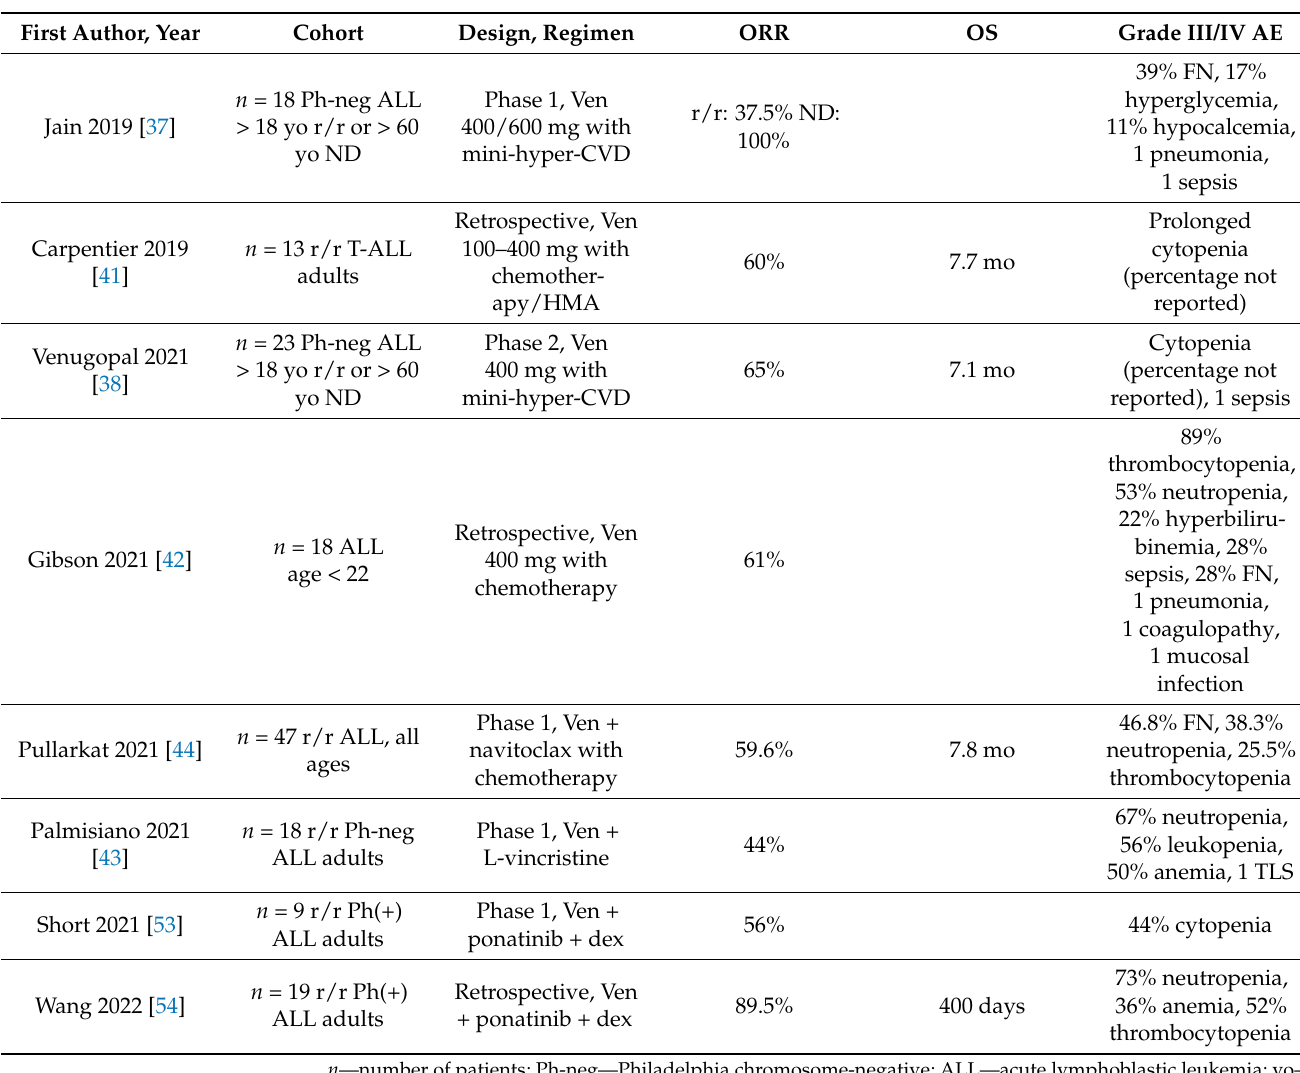
Table 1. Significant clinical studies with venetoclax-based combinations.